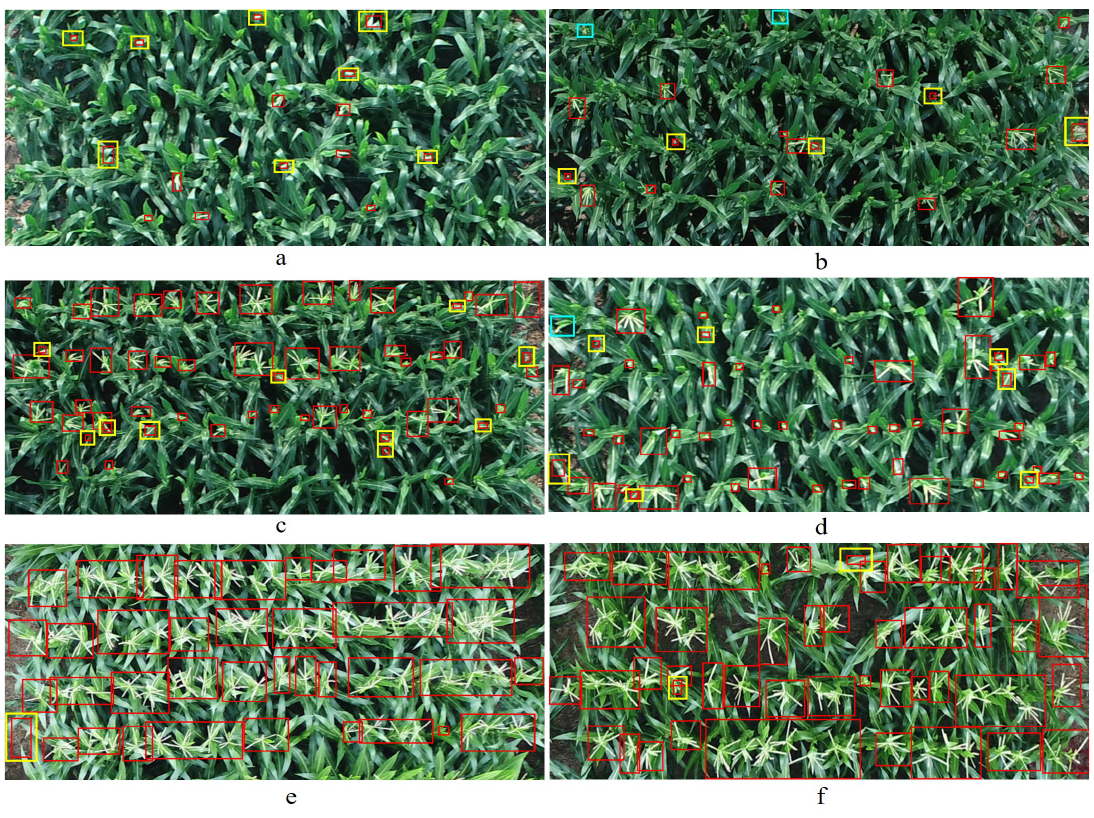
Figure 11. Detection results of tassels. The red boxes, blue boxes, and yellow boxes in the figure automatically represent detection, absent detection, and incorrect detection by proposed method respectively.